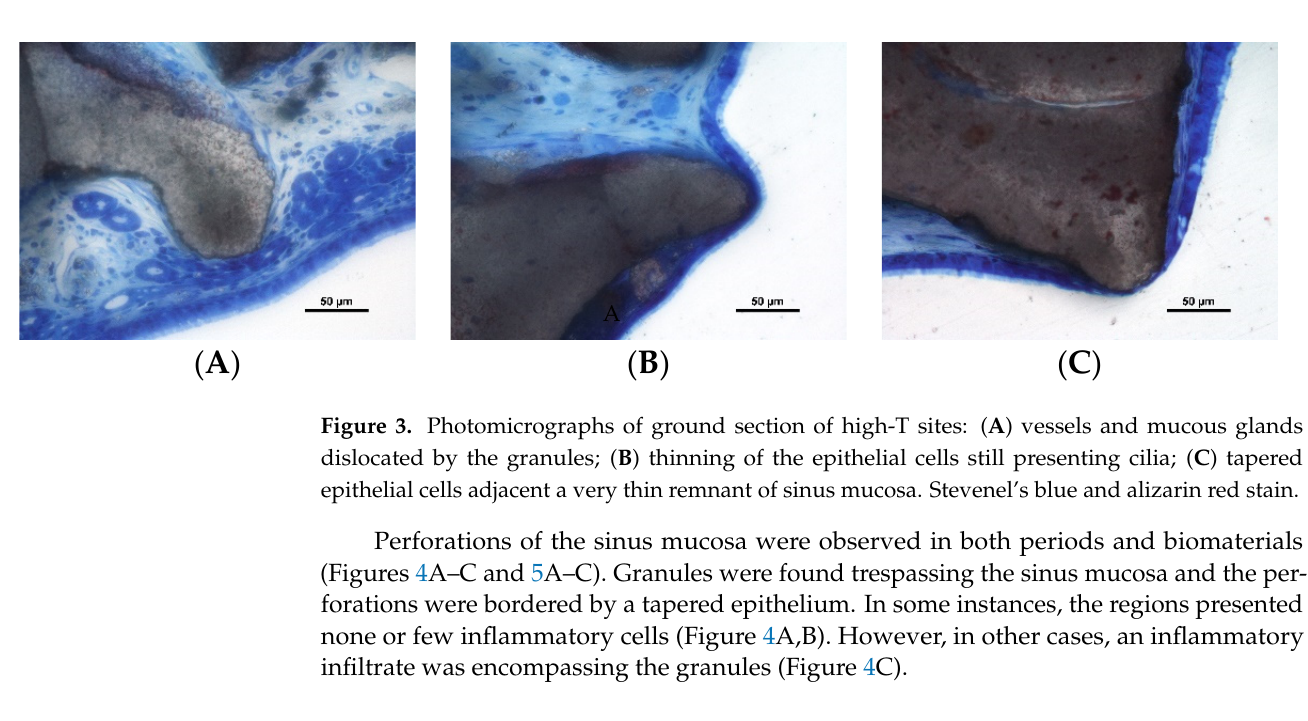
Figure 2. Photomicrographs of ground section of low-T sites: ( A ) vessels and mucous glands dislocated by the granules; ( B ) thinning of the epithelial cells; ( C ) tapered epithelial cells adjacent a very thin remnant of sinus mucosa. Stevenel’s blue and alizarin red stain.